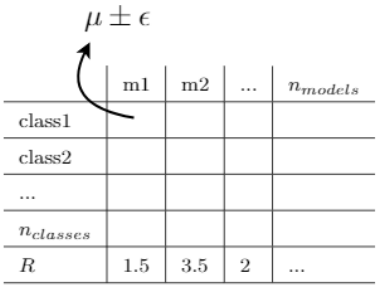
Figure 1. Definition of the robustness term R . Please note that m1 and m2 correspond to two different models, and class1 and class2 indicate two distinct classes. Additionally, the values in the cells of the last row are just example